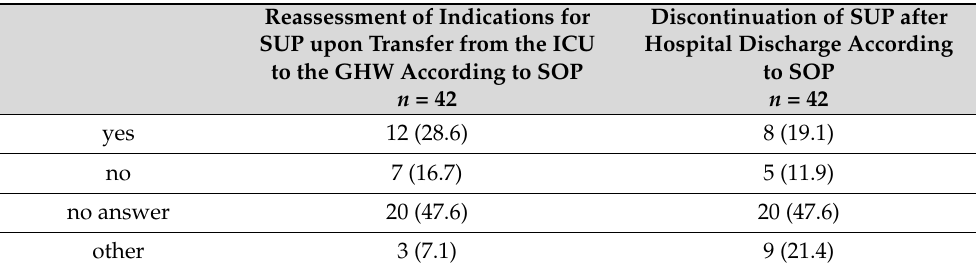
Table 4. Content of the SUP-SOP according to the MSM answers. MSMs confirming the existence of a SUP in their departments were asked whether routine reassessment of the indication for SUP transfer from the ICU/ICM to the GHWs and whether SUP discontinuation after discharge was specified in the SOP. Percentages were calculated in relation to the number of MSMs confirming the existence of an SOP in their department ( n =